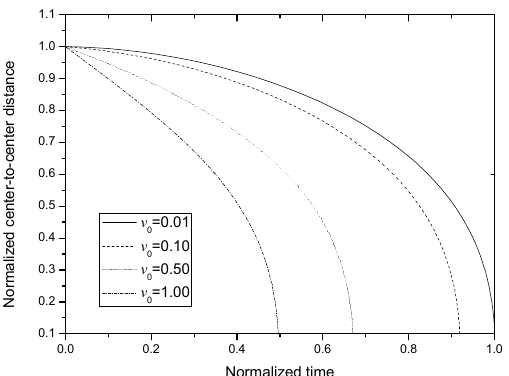
Figure 4. Numerical solution for the strict kinetic model in Equation (12) when M/N = 1 and y 0 = 1.